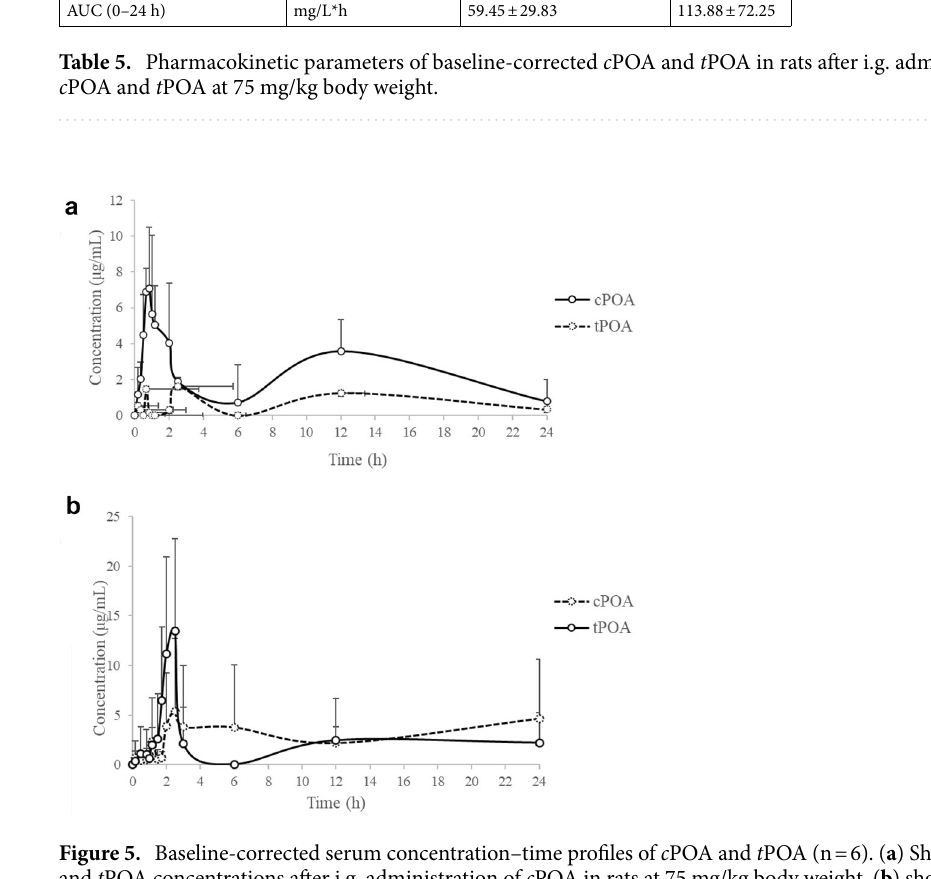
Figure 5. Baseline-corrected serum concentration–time profiles of c POA and t POA (n = 6). ( a ) Showed c POA and t POA concentrations after i.g. administration of c POA in rats at 75 mg/kg body weight, ( b ) showed c POA and t POA concentrations after i.g. administration of t POA in rats at 75 mg/kg body